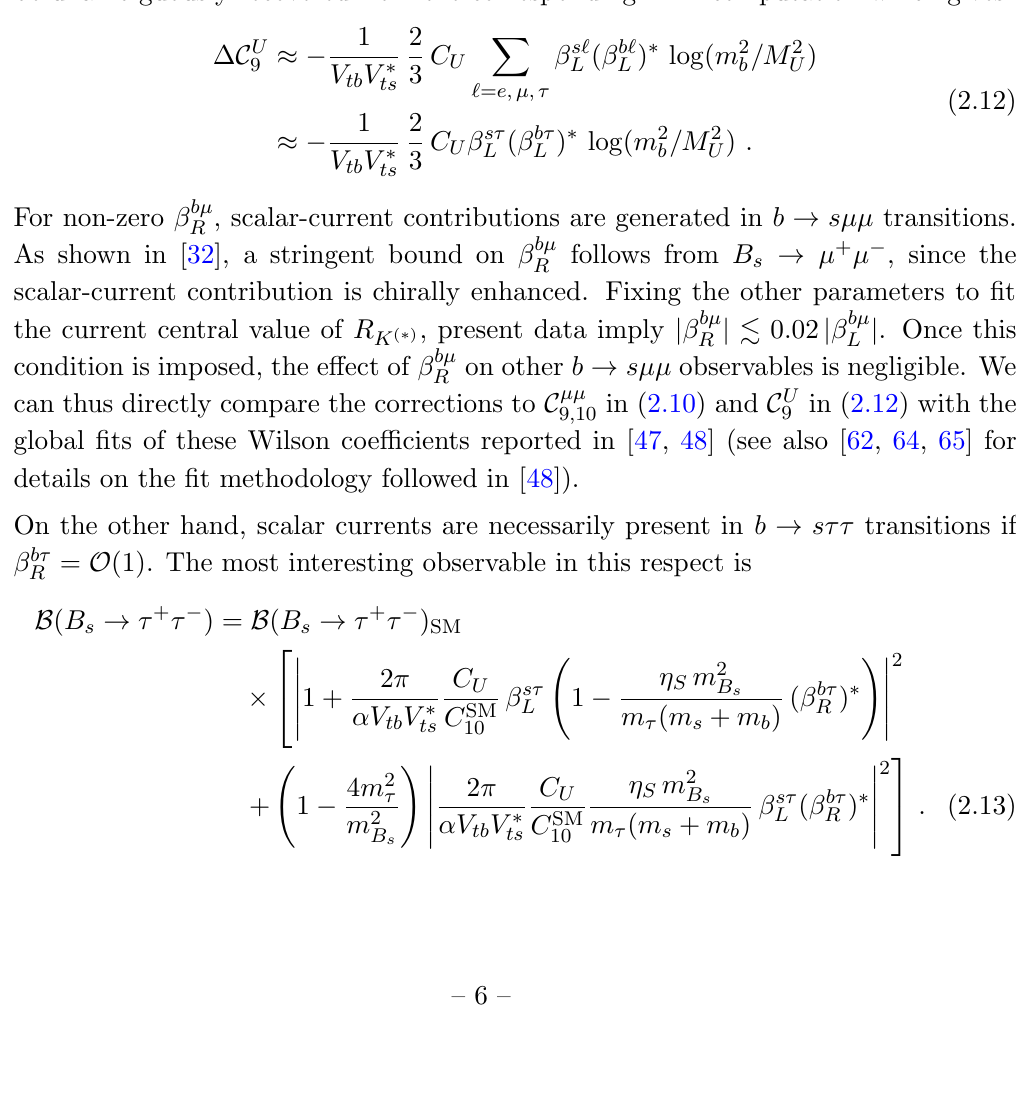
Figure 1 . SU(2) L -singlet vector leptoquark NP projections for R D and R D (cid:3) as a function of (cid:12) b(cid:28) together with the latest experimental world average (in red) and the SM prediction. For illustration, we also show the experimental 1 (cid:27) HFLAV combination [60] (in green), previous to the inclusion of preliminary Belle data announced in